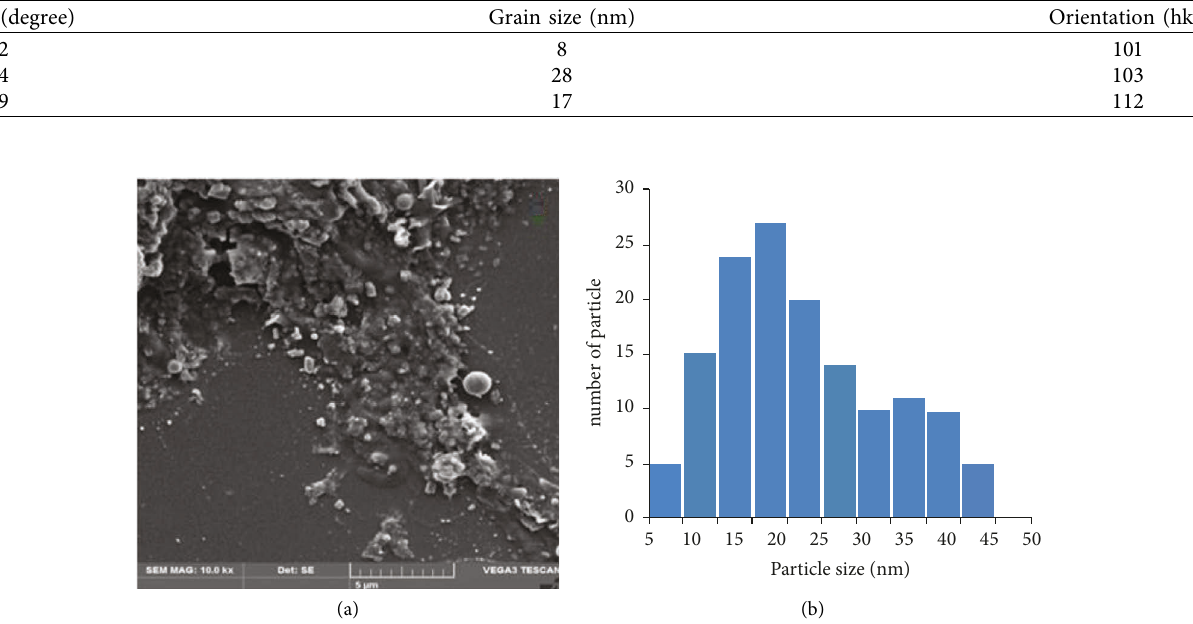
Figure 2: (a) SEM image of TiO